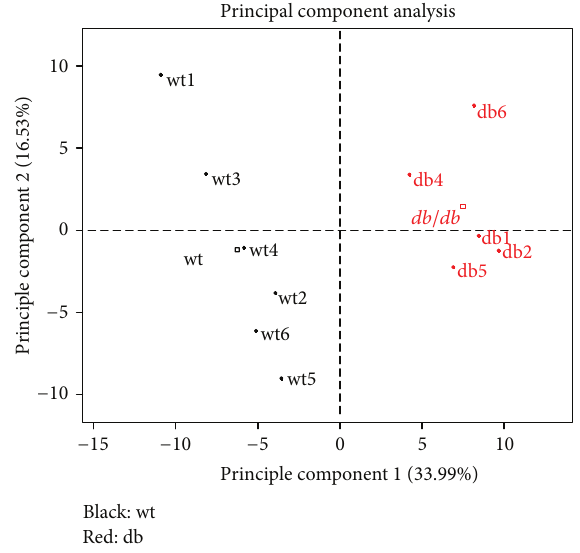
Figure 2: Principal component analysis separating individual mice. Principal components are calculated based on plasma metabolite levels (wt: wild-type mice, db: 𝑑𝑏/𝑑𝑏 −/−